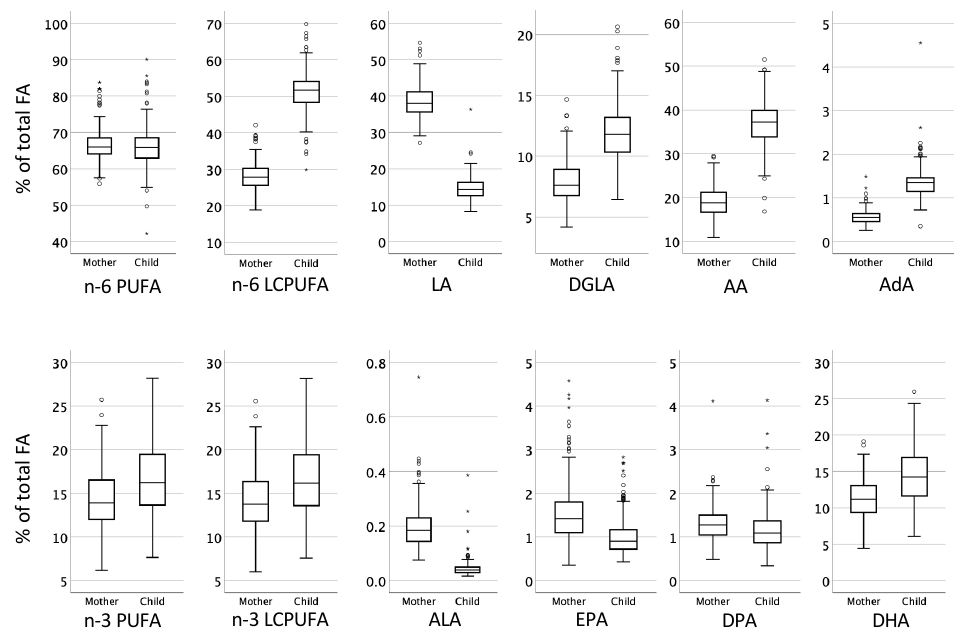
Figure 2. Proportions of fatty acids in the maternal and infant plasma samples at delivery. Ab- breviations: PUFA, polyunsaturated fatty acids; LCPUFA, long-chain PUFA; LA, linolenic acid (18:2 n-6); DGLA, dihomo-gamma-linoleic acid (20:3 n-6); AA, arachidonic acid (20:4 n-6); AdA, Adrenic acid (22:4 n-6); ALA, α -linolenic acid (18:3 n-3); EPA, eicosapentaenoic acid (20:5 n-3); DPA, docosapentaenoic acid (22:5 n-3); DHA, docosahexaenoic acid (22:6 n-3).